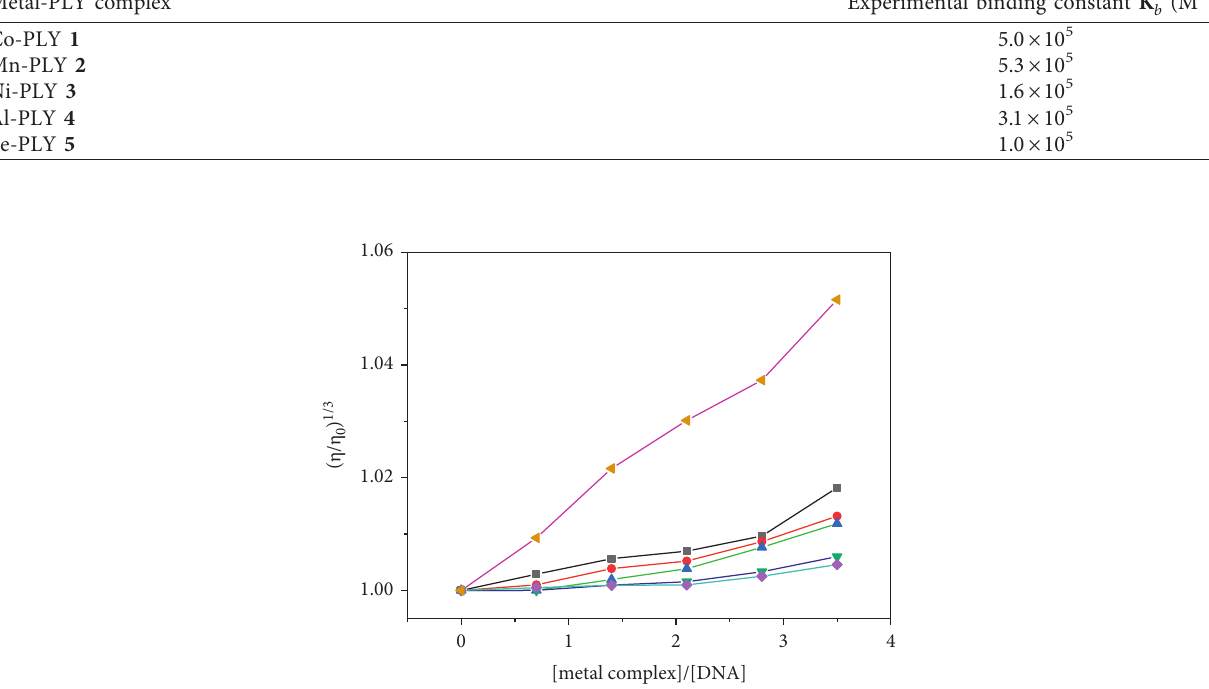
Table 6: Experimental values of binding constant ( K Metal-PLY complex